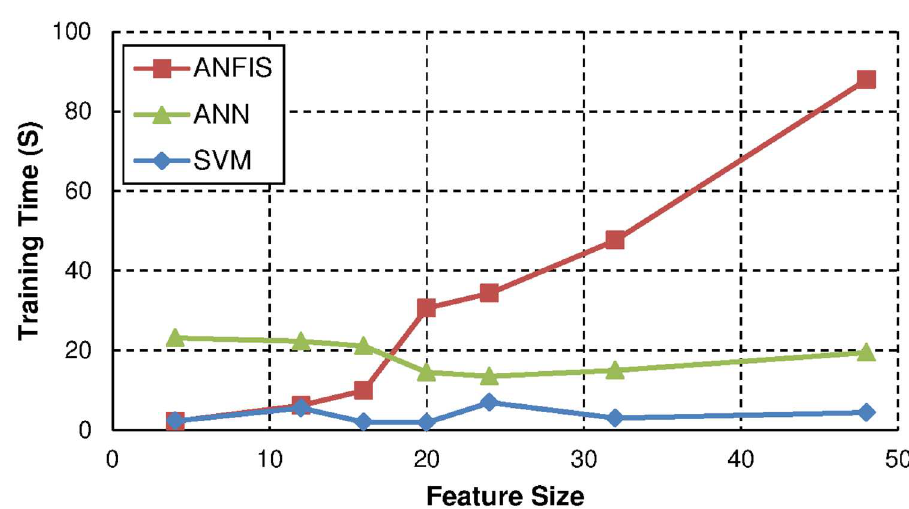
Fig 4. Training time vs feature size for PD